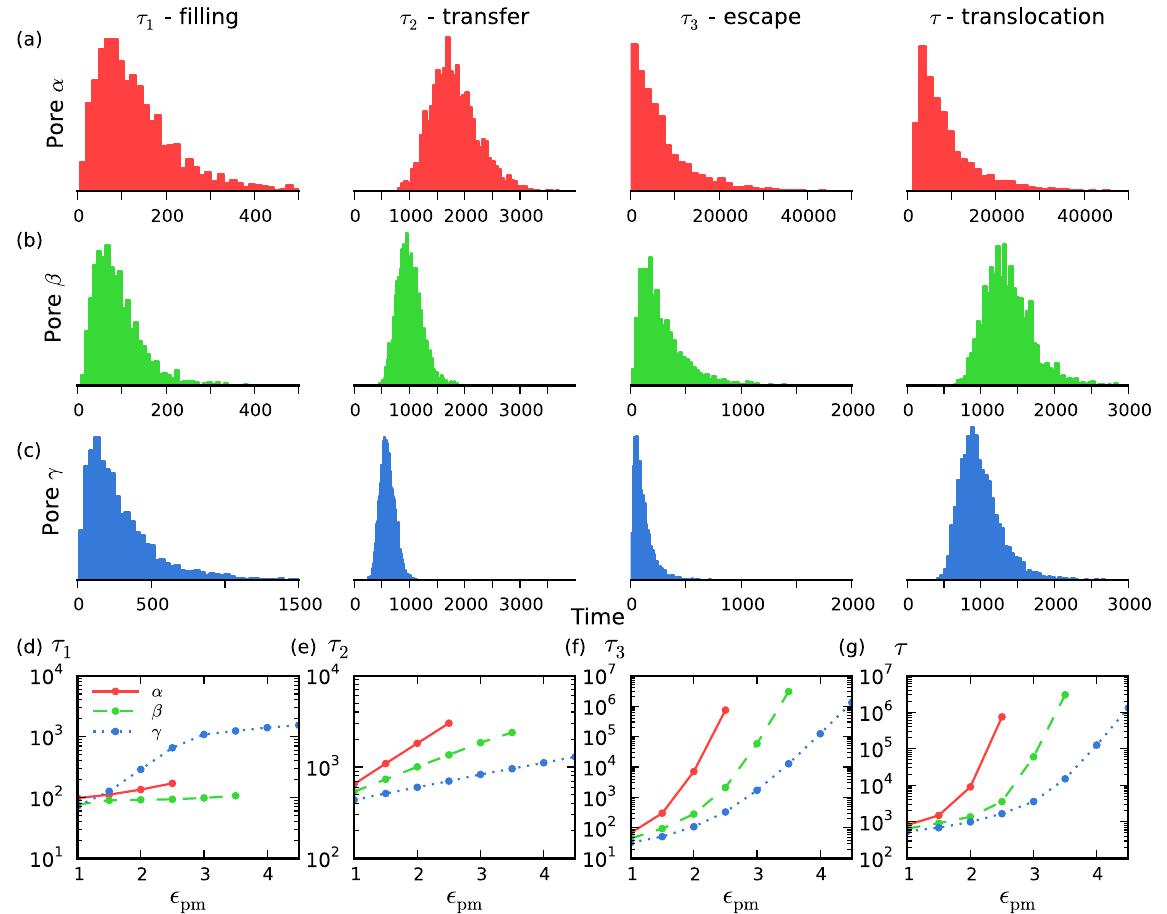
FIG. 2. Translocation time statistics for homopolymers. (a), (b), and (c) Comparison of translocation time distributions for the three patterned pores, for F ¼ 0 : 5 and (cid:1) pm ¼ 2 : 0 . The filling, transfer, and escape distributions are similar across the three pores, but have distinctly different scales (e.g., average and variance), such that the overall translocation time distribution for the three pores is discernibly different. (d), (e), and (f) Comparison of average filling, transfer, and escape times for the three different pores for F ¼ 0 : 5 as a function of (cid:1) pm . While the filling time shows only a moderate dependence on the stickiness, and the transfer time exhibits an exponential dependence on (cid:1) pm , the dependence of the escape time is even faster than exponential. (g) The total translocation time for the three pores as a function of (cid:1) pm indicates that for small forces, the escape time dominates the translocation process. The orders of magnitude differences in the translocation times between different pores show the extraordinary sensitivity of the translocation dynamics on pore